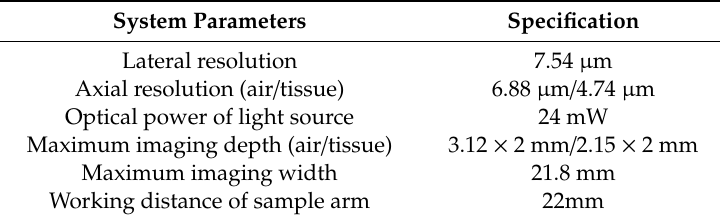
Figure 2. Schematic diagram of the SD-OCT system. PC: polarization controller, M: mirror, and N: neutral density filter. Table 1. The parameters of the SD-OCT system.